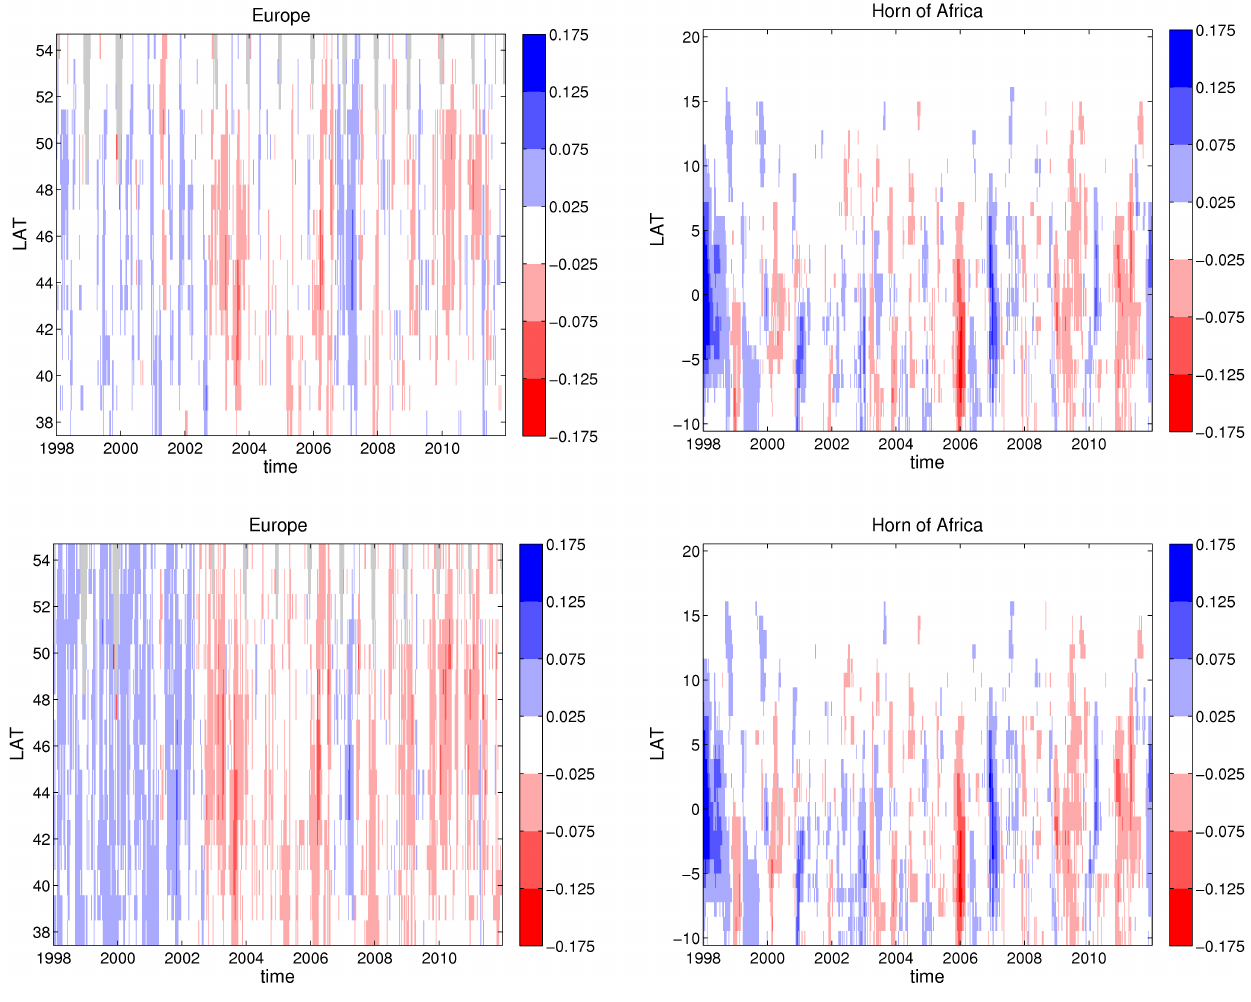
Horn of Africa ( right ), employing the harmonized ( top ) and the original ( bottom ) products. Positive ( negative ) anomalies, corresponding to values greater ( lower ) than the 14-year mean are displayed in bluish ( reddish ) tones. Periods with no FAPAR data are plotted as grey